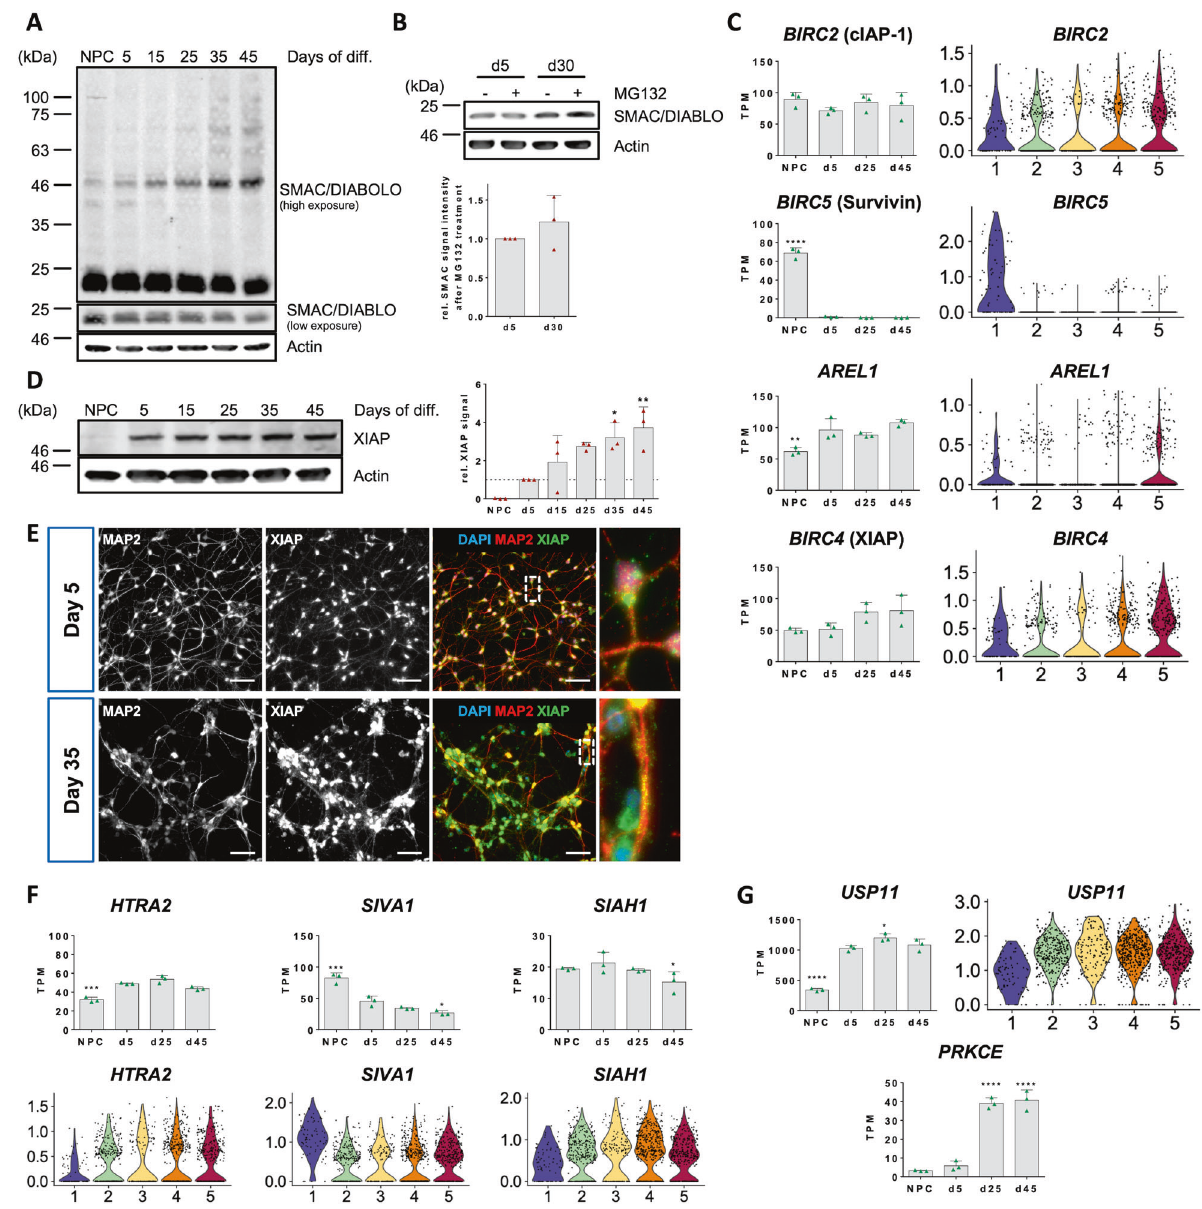
Fig. 3 The inhibitor of apoptosis protein XIAP is a cornerstone of neuron survival competence. A Western blot of the pro-apoptotic mitochondrial protein SMAC/DIABLO. Top panel shows high exposure of a Western blot over the time course of neuronal maturation. Mature SMAC is detected slightly below 25 kDa. Middle panel shows band of mature SMAC from top panel at lower exposure. B Western blot showing inhibition of protein turnover by treatment with MG132 (5 µM) for 16 h in d5 and d30 neuronal cultures. Bar graph shows mean with S.D. of n = 3 experiments. C Expression pro fi les of known SMAC E3 ubiquitin ligases. Bar graphs show mean with S.D., one-way ANOVA with d5 expression as reference for statistical analysis (left row). Violin plots showing cluster-speci fi c abundance of the same genes in scRNAseq (right row). D Representative Western blot of XIAP protein levels during neuronal maturation. Quanti fi cation shows relative signal intensity of XIAP Western blot band compared to d5. Bar graph shows mean with S.D., one-way ANOVA with Bonferroni correction. E Representative immuno fl uorescence images of XIAP in d5 and d35 neuronal cultures. White dashed boxes indicate picture area of the zoom-in on the right. Scale bars, 50 µm. F RNAseq and scRNAseq data of XIAP inhibitory proteins and ( G ) proteins involved in protecting XIAP from degradation. Bar graphs show mean with S.D., one-way robust BIRC4 expression but did not show notable amounts of of neurons. BIRC4 (XIAP) also showed a trend towards increased XIAP protein in Western blots suggesting involvement of expression in more mature neuronal cultures in bulk RNASeq. This mechanisms for post-transcriptional downregulation of XIAP in effect was even more pronounced on the single cell level, on NPCs. Finally, we investigated changes in the expression of which the highest XIAP mRNA levels were detected in cluster 5 reported XIAP antagonists aside from SMAC. Expression of the (Fig. 3C). Evaluation of XIAP protein levels revealed an almost mitochondrial serine protease HTRA2 [17] peaked at d25 and then 4-fold increase of XIAP protein in day 45 compared to day 5 decreased again (Fig. 3F). Furthermore, mature neurons expressed neurons (Fig. 3D) and this notion was supported by immuno- fl uorescence experiments (Fig. 3E). Interestingly, NPCs possessed signi fi cantly less of the XIAP ubiquitinating enzymes SIVA1 [18]